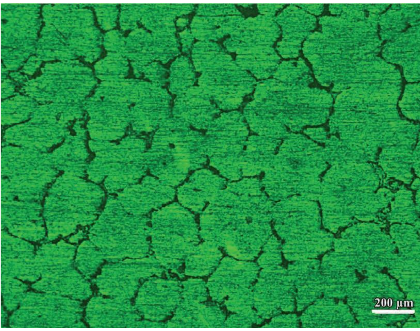
Figure 6: Optical micrographs of the section bonded at 500 ° C.